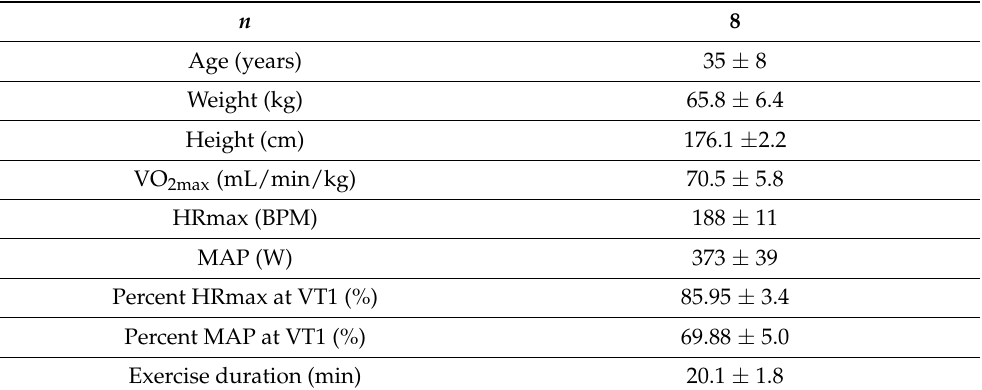
Table 1. Subject